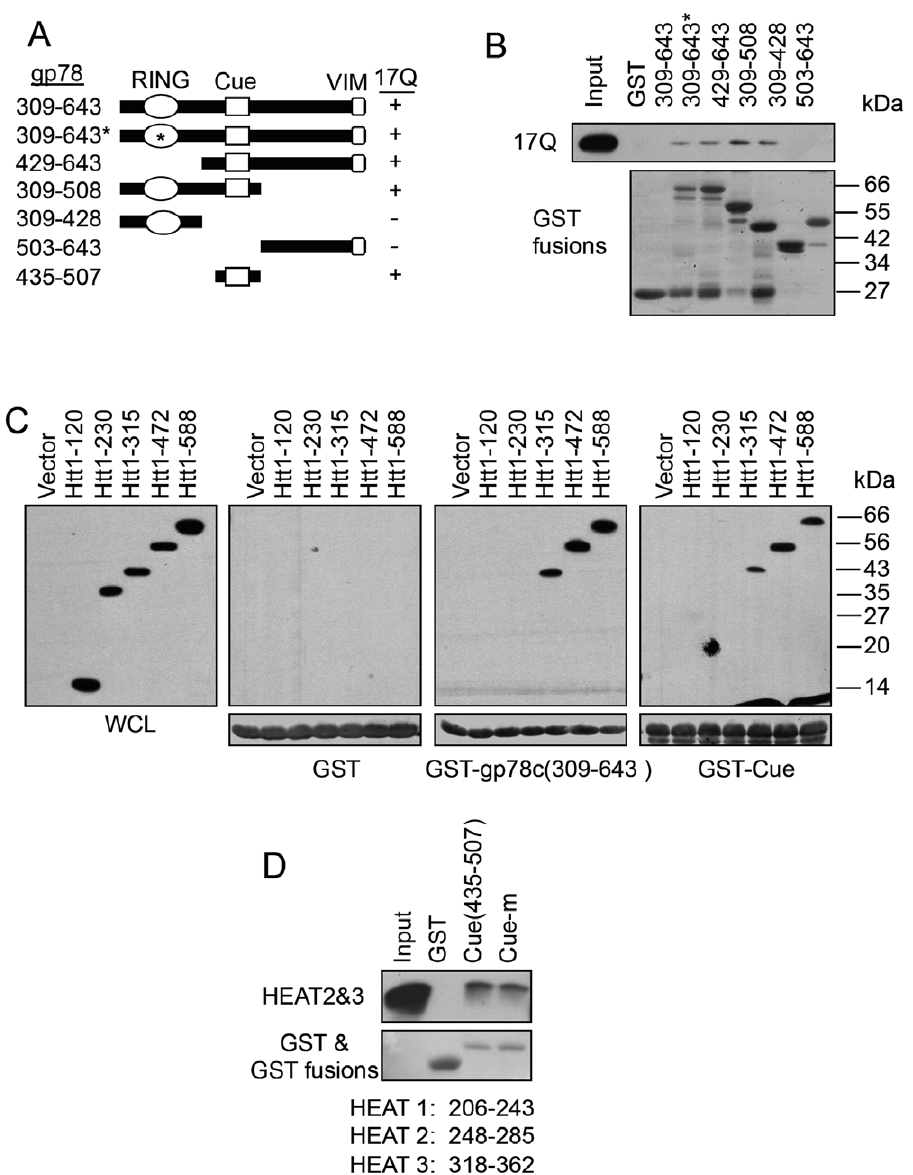
Figure 4. The cue domain of gp78 interacts with the HEAT 2 & 3 repeats of htt. A. The cue domain of gp78 is responsible for its interaction with htt. Left: Diagram shows GST-gp78c and its truncation mutants used in pull down assay. Right: GST-gp78c and its truncation mutants were incubated with HEK293 cell lysates expressing Nhtt17Q. The Nhtt17Q associated with GST-gp78 was detected with anti-FLAG antibody. GST fusion proteins were stained by ponceau s red. B. The cue domain of gp78 interacts with a region containing the HEAT 2&3 repeats of htt. HEK293 cell lysates expressing various Nhtt truncation mutants containing 17Q were subjected to GST pull down experiment with GST-gp78c and its mutants. Nhtt mutants were detected by immunoblotting. C. Direct interaction of the cue domain of gp78 and the HEAT 2&3 repeats. Recombinant 6His- tagged HEAT 2&3 protein was incubated with GST, GST-cue domain or a GST-Cue domain mutant (Cue-m, see Figure 5A for detailed amino acid changes). Binding of HEAT 2&3 was detected by immunoblotting for 6-His. GST and its fusion proteins were stained by ponceau s